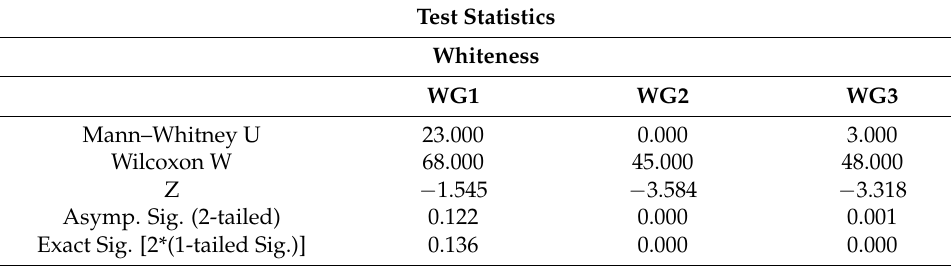
Table A7. Test statistics table of Mann–Whitney U test for the whiteness according to the WG type.